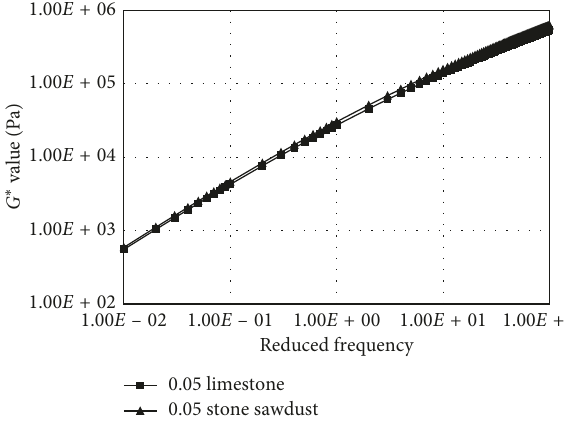
Figure 19: G value master curve for the two mastics (VR ∗